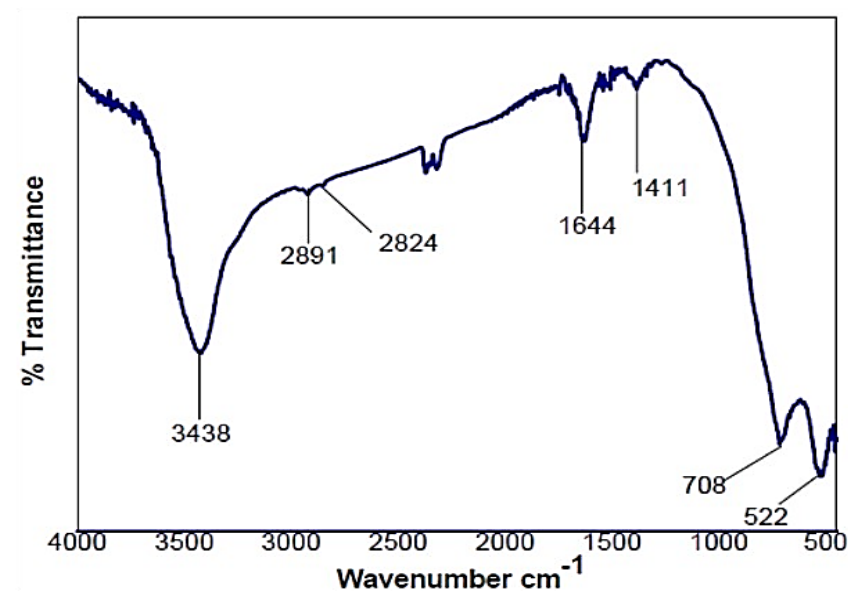
Figure 8. FTIR spectra of MgAl 2 O 4 NPs.